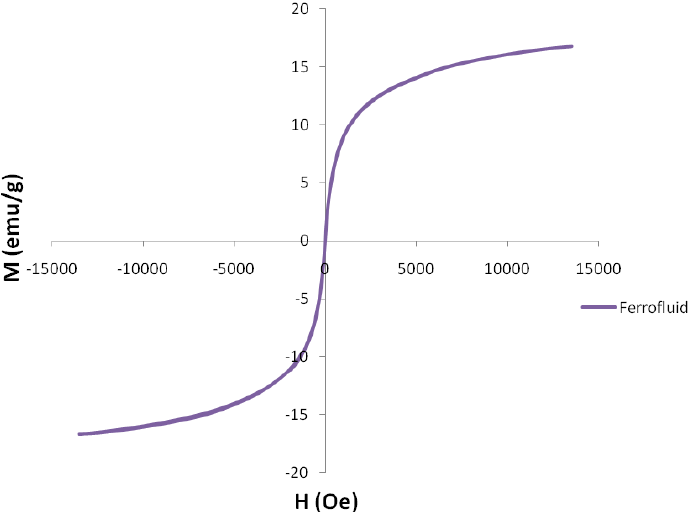
Figure 5. The magnetized curve of 1M ferrofluid measured by a VSM.